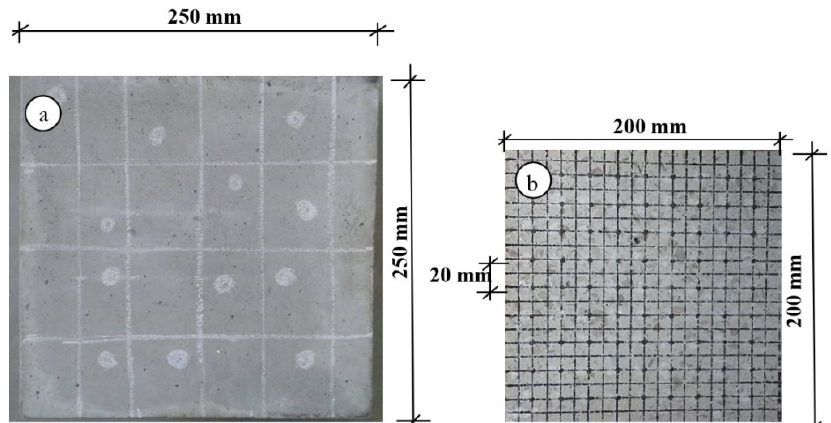
Figure 2. Self-compacting concrete plates used in sclerometry, a) for the analysis based on the NBR 7584 standard [13] and b) for the analysis of indentation with sclerometer on a regular